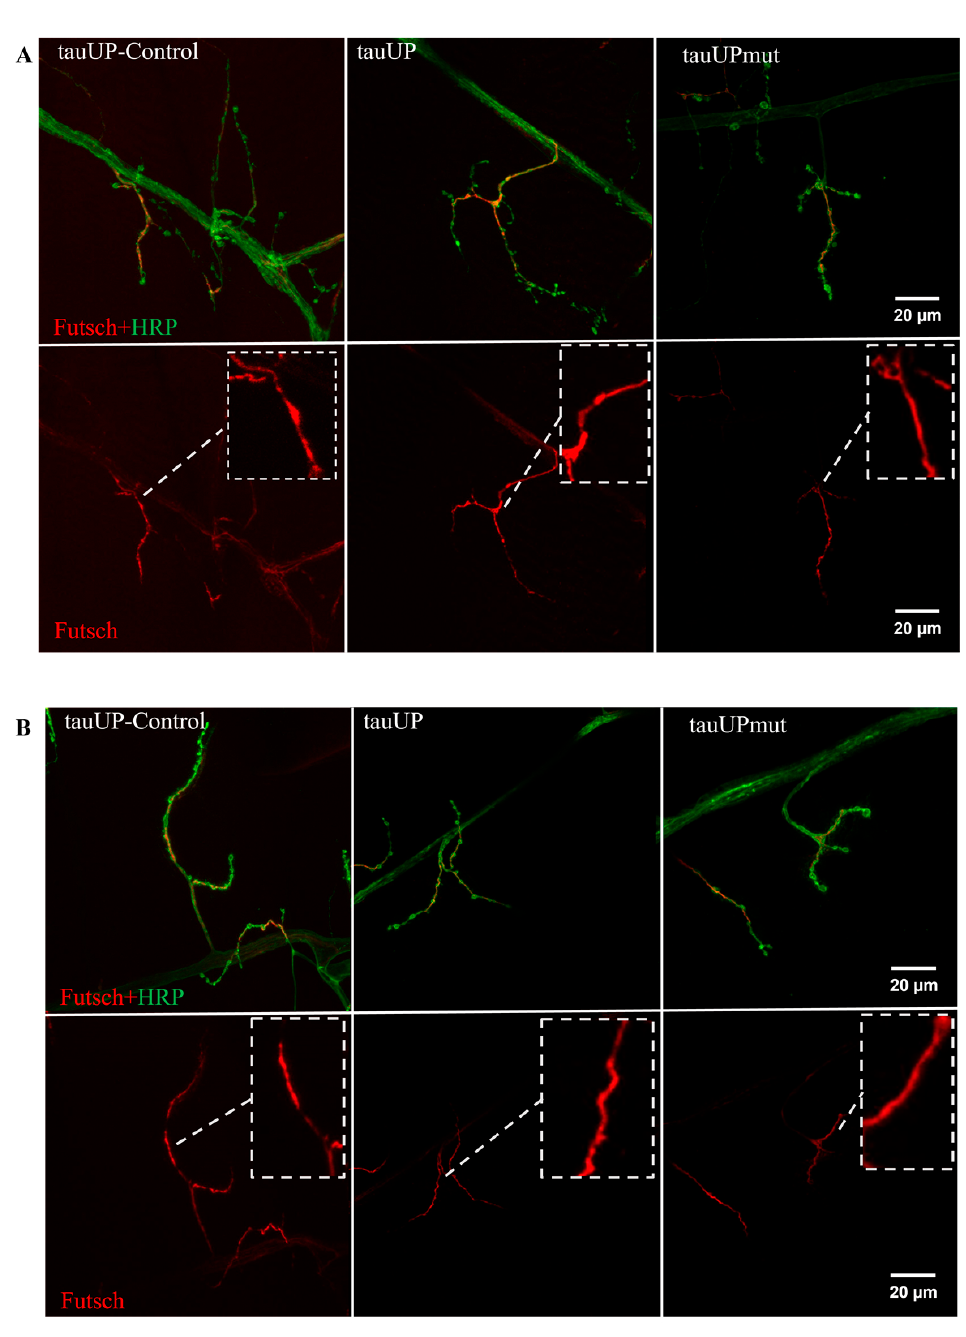
Figure 6. Increased expression of the normal and mutant RA transcript of the tau gene does not change the distribution of Futsch protein in males and females. ( A )—Immunostaining in males. ( B )—Immunostaining in females. A detailed description of the genotypes is given in the Materials and Methods